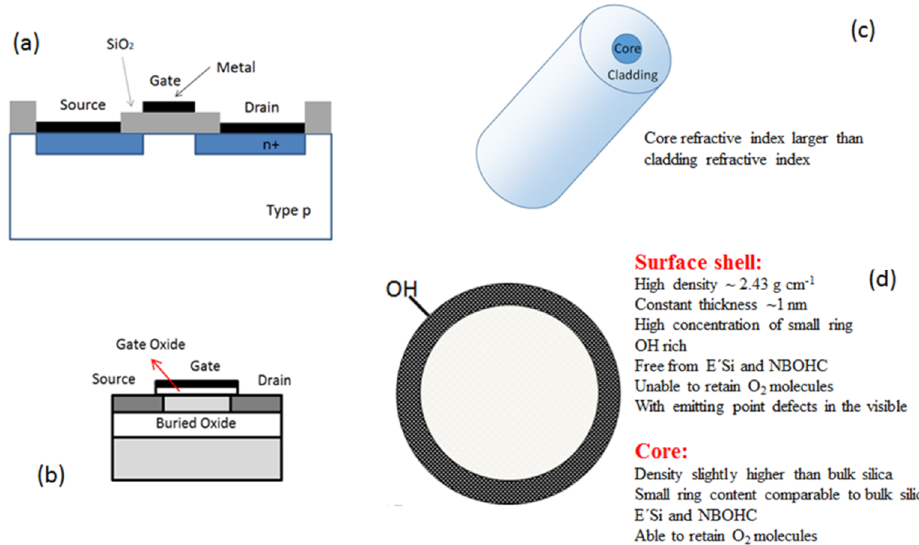
Figure 1. ( a ) Scheme of a MOSFET (MOS Field Effect Transistor) inspired by [1,2]; ( b ) Scheme of a silicon-on-insulator (SOI) according to that reported in [2]; ( c ) Optical fiber basic representation with core and cladding; ( d ) Scheme of a silica nanoparticle with some of the characteristics obtained in [30–41].